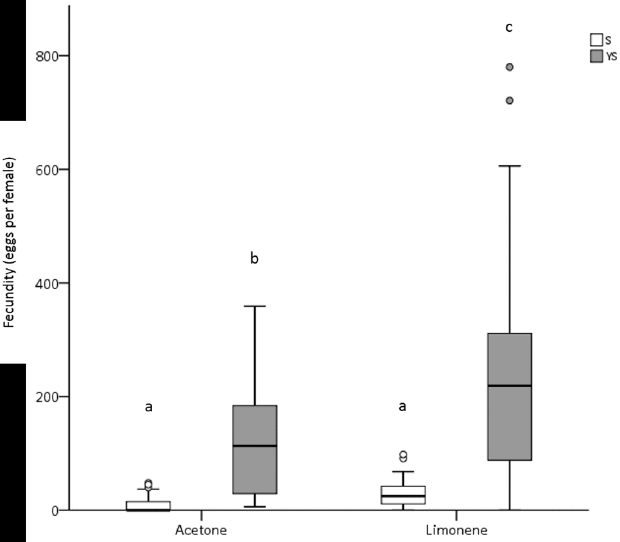
Fig 3. Box plots depicting fecundity distributions of females fed with either S or YS that were exposed to acetone (control) and to limonene LD 20 . Different letters indicatesignificantdifferencesamong female cohorts (Bonferroni adjustment, P < 0.001 in all